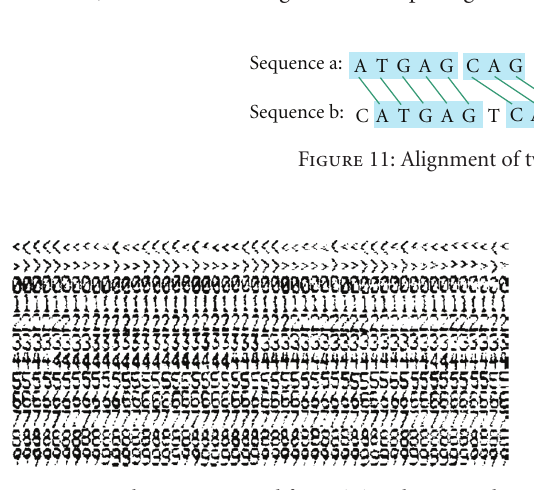
Figure 12: Character set used for training the network.